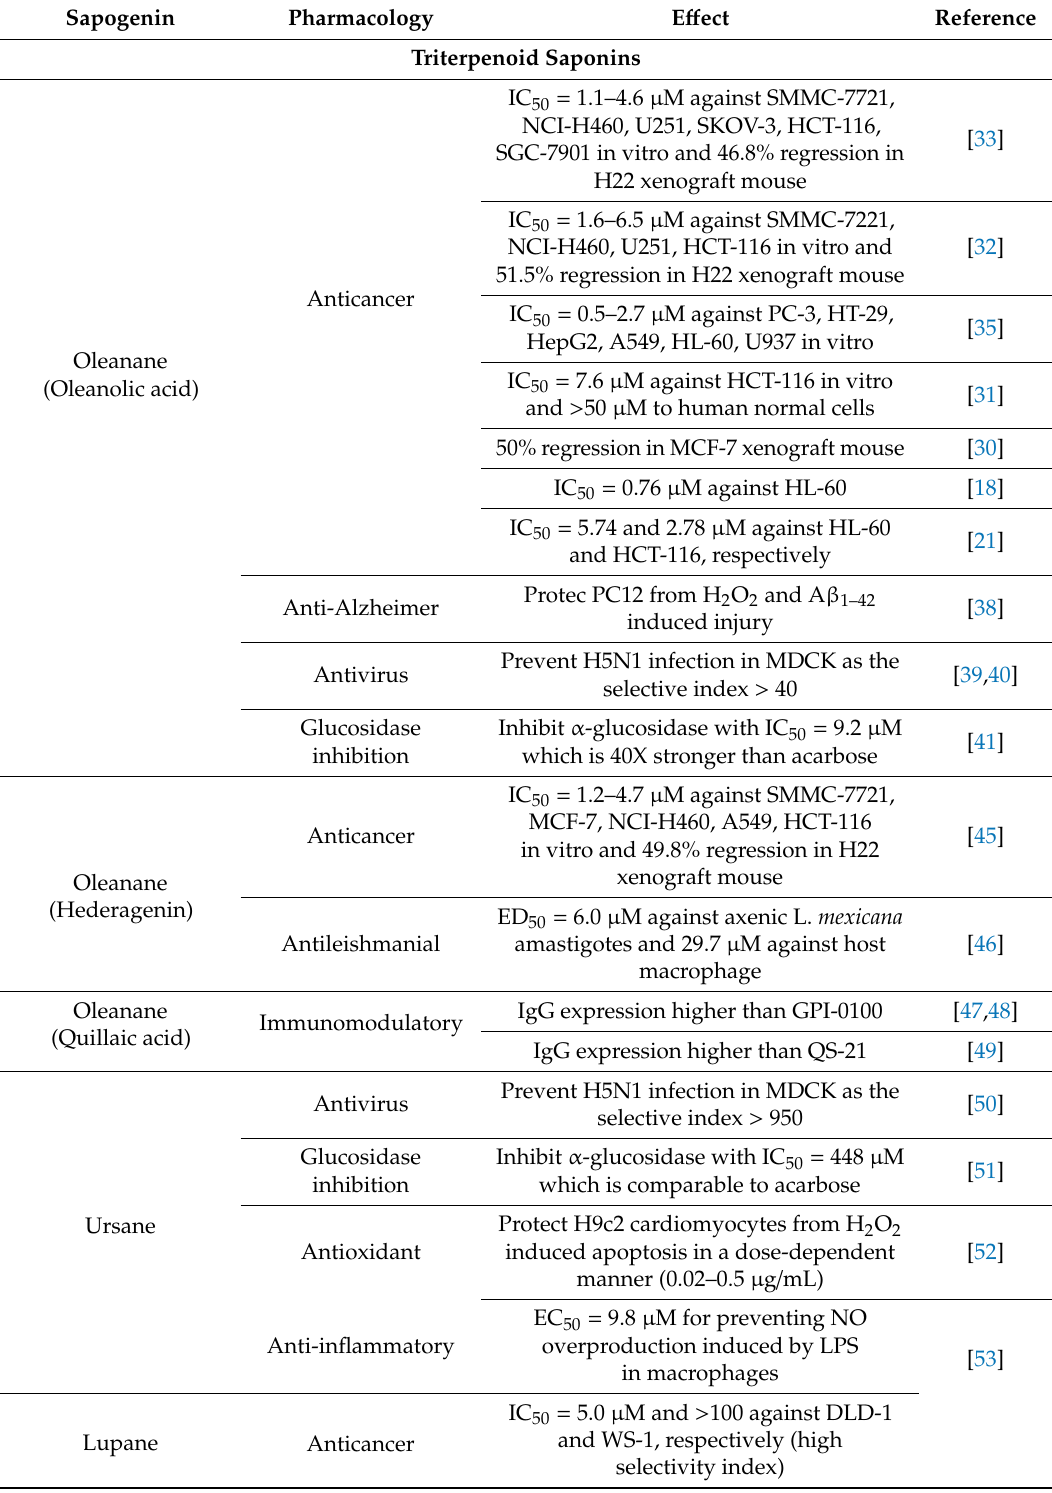
Table 1. Biological e ff ects of the synthetic